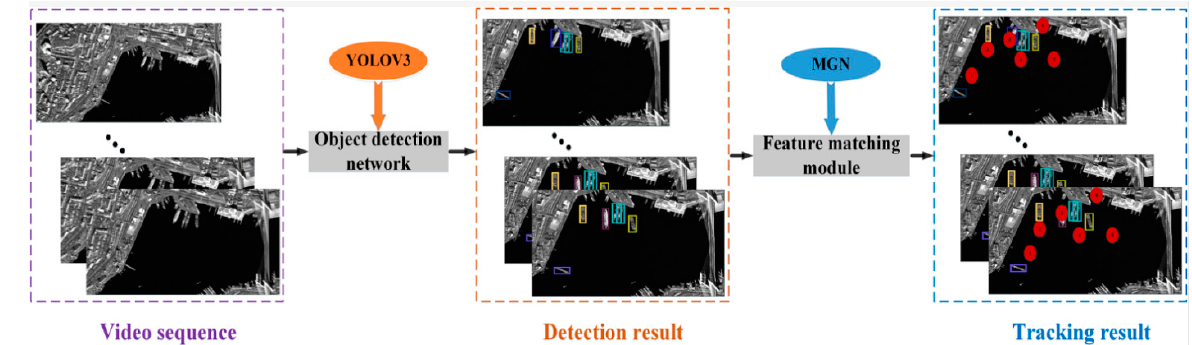
Figure 1. Detection and segmentation effect on our proposed method.